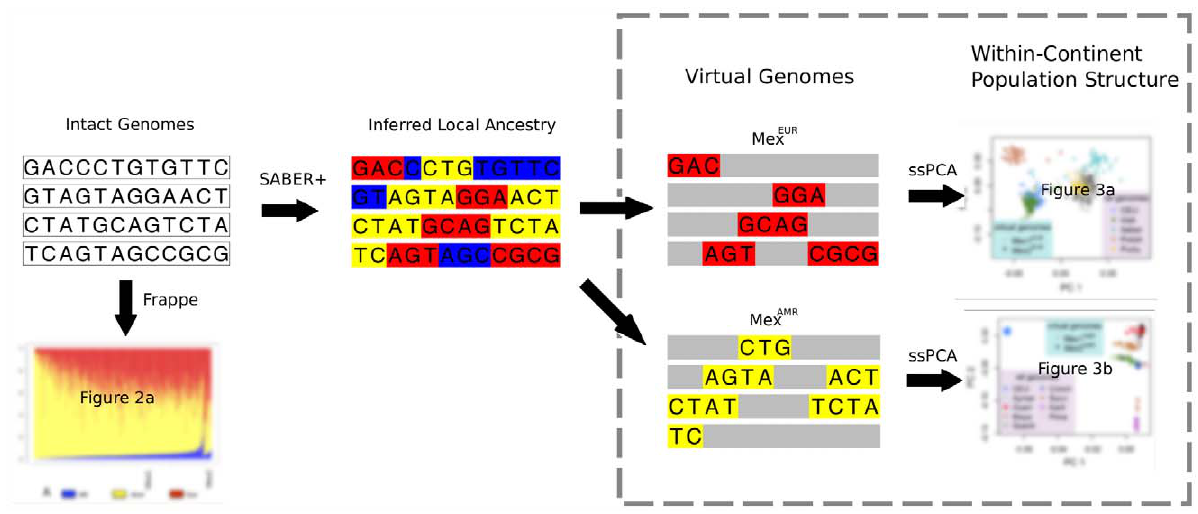
Figure 1. Schematic describing the analytic framework for characterizing continental-level and within-continent populations structure in an admixed population. For virtual genomes, haplotypes from all but one ancestral population are ‘‘masked’’ as missing data.